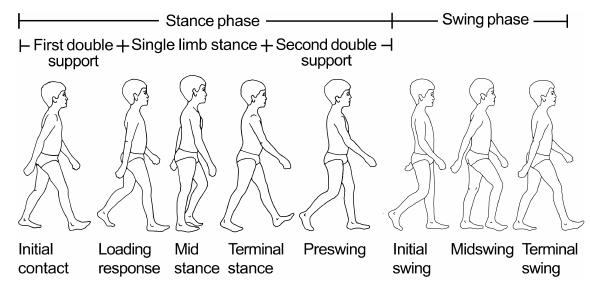
Figure 2. Walk cycle dynamics